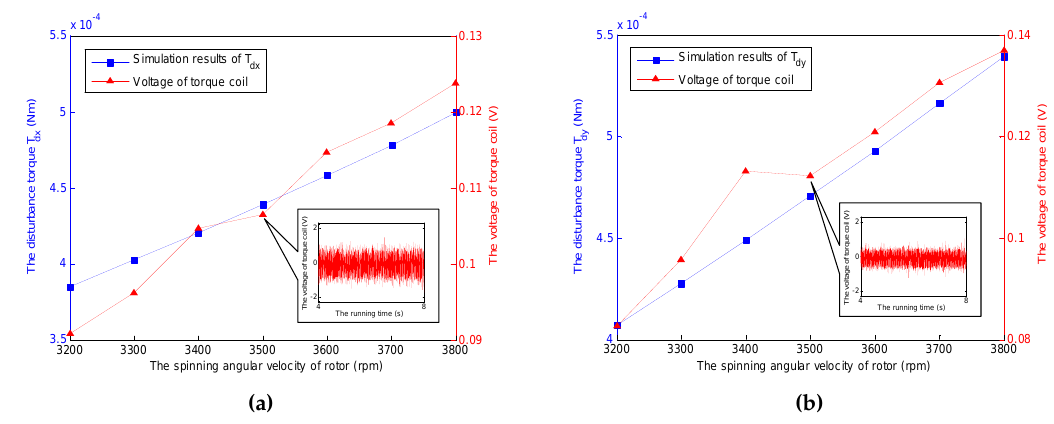
Figure 16. Comparisons of T dx and T dy with varying angular velocities under φ x = 3 ◦ and φ y = 0 ◦ . ( a ) Comparison of T dx ; ( b ) Comparison of T dy .